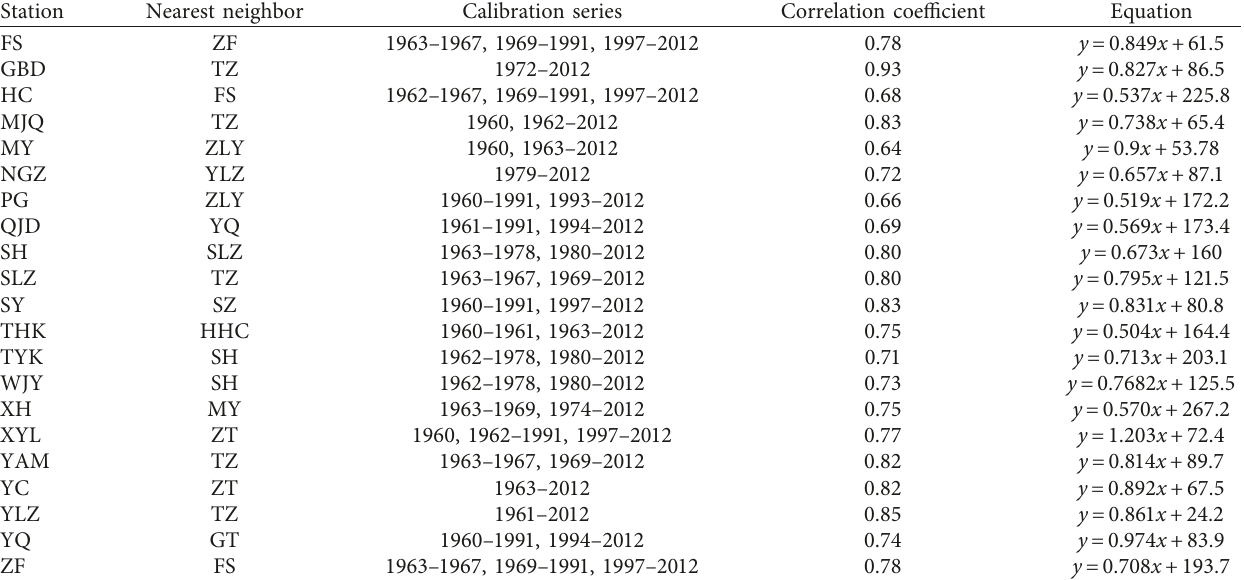
Table 2: Information for infilling missing